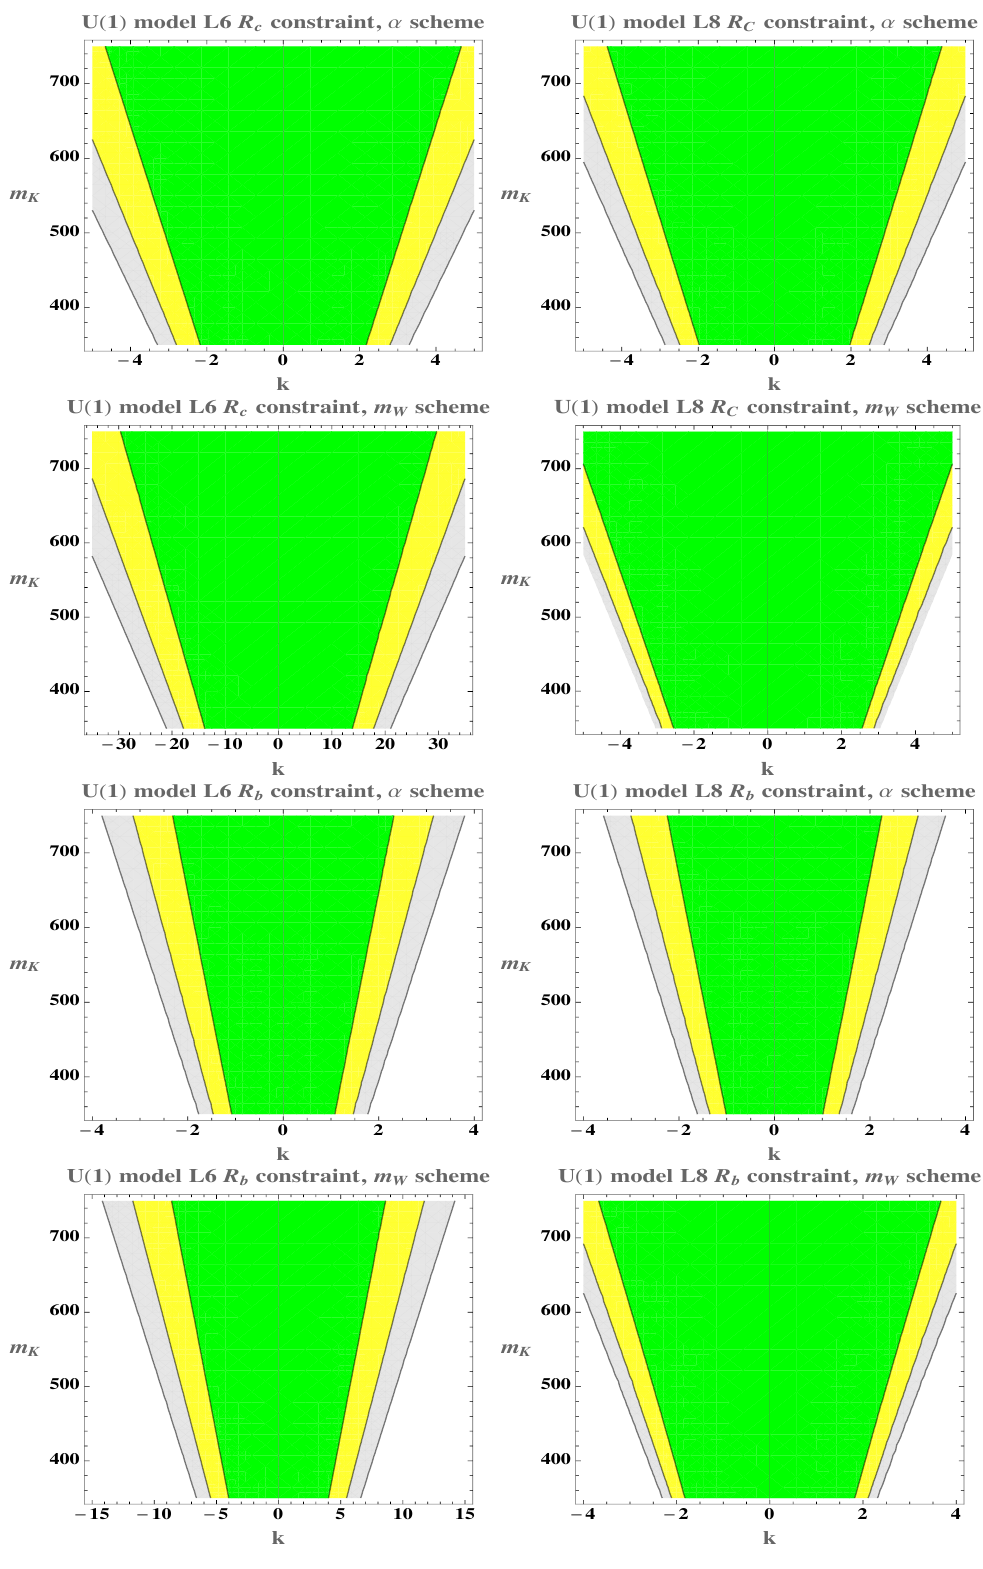
Figure 5 . Shown are the constraints on the model space from the R c and R b EWPD